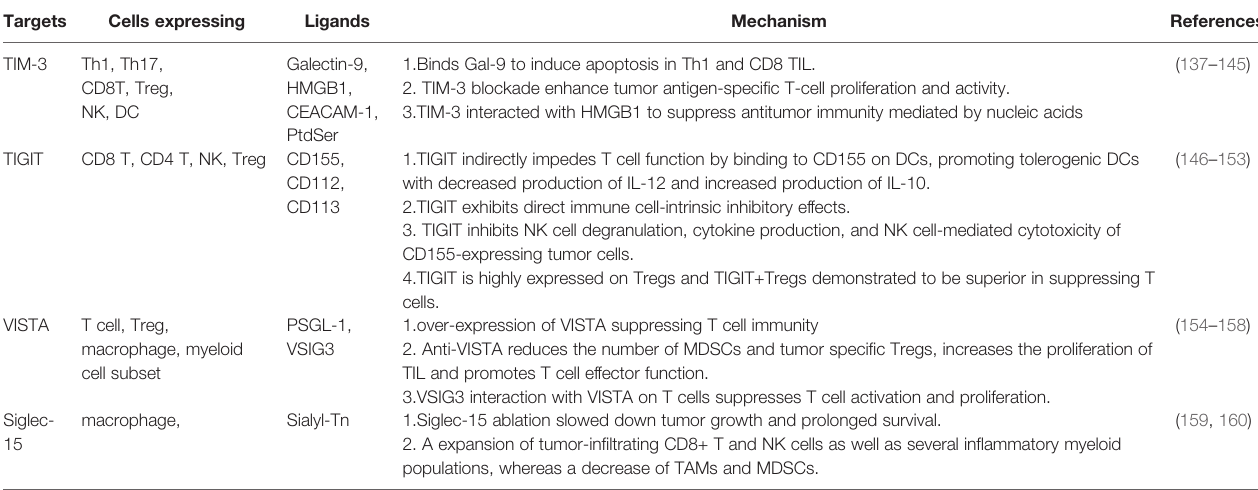
TABLE 2 | Functions of new immune